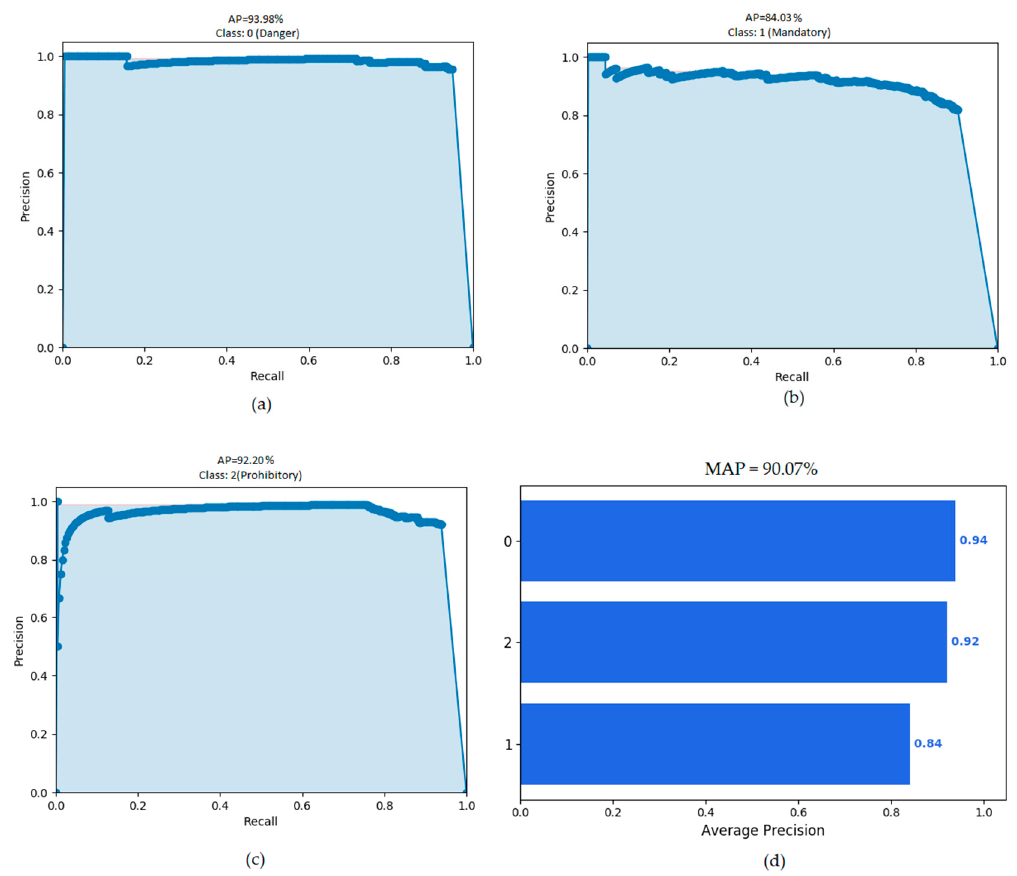
Figure 9. Best results achieved by ITSR on Korean Traffic Sign Dataset for three different classes: ( a ) average precision of danger class; ( b ) average precision of mandatory class; ( c ) average precision of prohibitory class; and ( d ) mean average precision of all three classes.